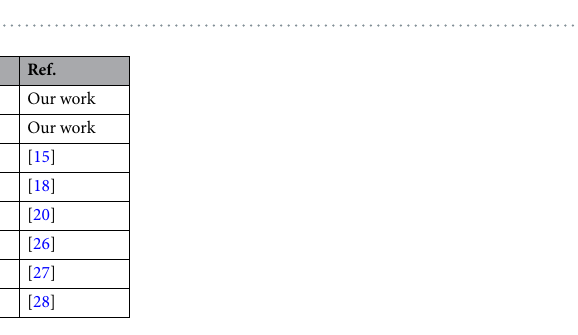
Figure 3. Thermal conductivity of the Fe 3 O 4 /LDPE and M-Fe 3 O 4 /LDPE composites corresponding to thermal enhancements.